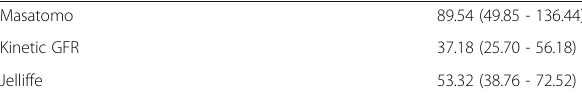
Table 2 (abstract 0165). GFR calculated with the creatinine values of the first 48 hrs